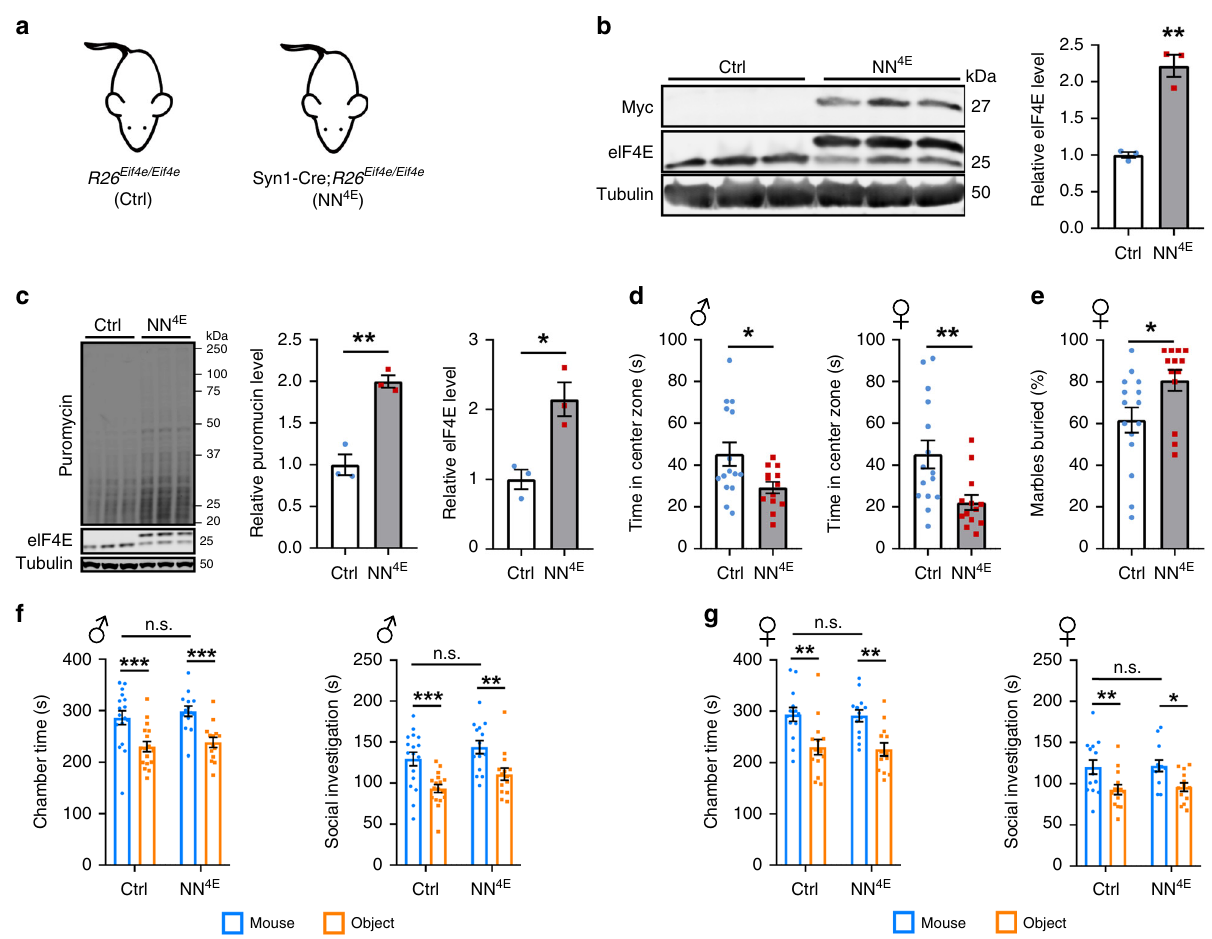
Fig. 1 Neuronal eIF4E overexpression elevates anxiety without altering social interaction. a Syn1-Cre; R26 Eif4e/Eif4e (NN 4E ) mice overexpress eIF4E in neurons, while R26 Eif4e/Eif4e mice serve as controls (Ctrl). b Levels of eIF4E in hippocampal extracts prepared from control and NN 4E mice. The eIF4E immunoblot reveals both endogenous eIF4E (lower band) and overexpressed eIF4E-Myc (upper band). Alpha tubulin was used as a loading control. n = 3 per genotype. ** p = 0.0015 by two-sided t -test. c Protein synthesis in cultured hippocampal neurons as revealed by puromycin incorporation. n = 3 mice per genotype. ** p = 0.0023 and * p = 0.015 by two-sided t -test. d Time spent in the central zone during the fi rst 5 min in open fi eld tests. Male: 15 control mice and 13 NN 4E mice; Female: 15 control mice and 13 NN 4E mice. ** p = 0.0076, * p = 0.0218 by two-sided t -test. e Percentage of marbles buried. n = 15 control mice and 13 NN 4E mice. * p = 0.0247 by two-sided t -test. f , g Sociability of male ( f ) and female ( g ) NN 4E mice as revealed in three-chamber sociability tests. Male: 17 control mice and 14 NN 4E mice; Female: 14 control mice and 13 NN 4E mice. Two-way analysis of variance (ANOVA) with Fisher ’